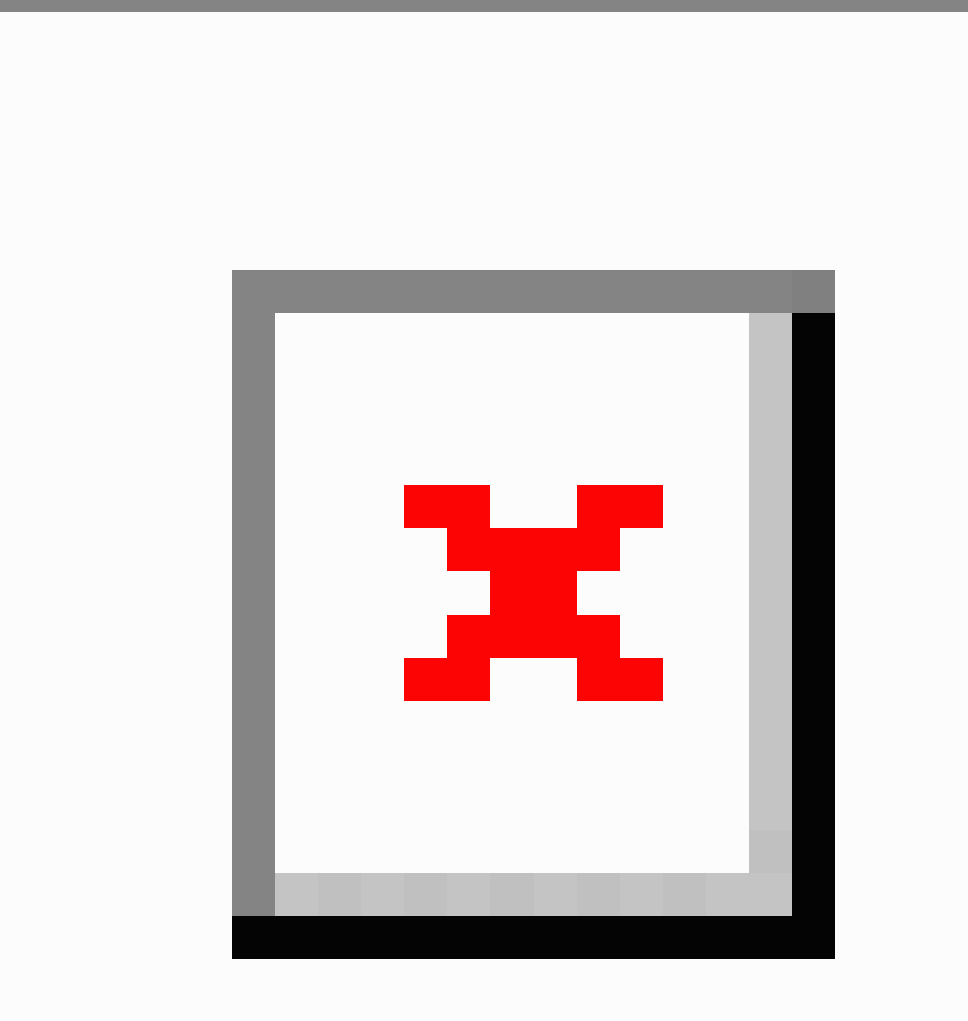
Figure 2. Flow of participants through the study. *Per practice, an unknown number of respondents was invited to participate due to some dispensers' noncompliance with the protocol to report this. The number of invited clients is an estimation based on the reported numbers of invited clients of the practices complying with the protocol to report